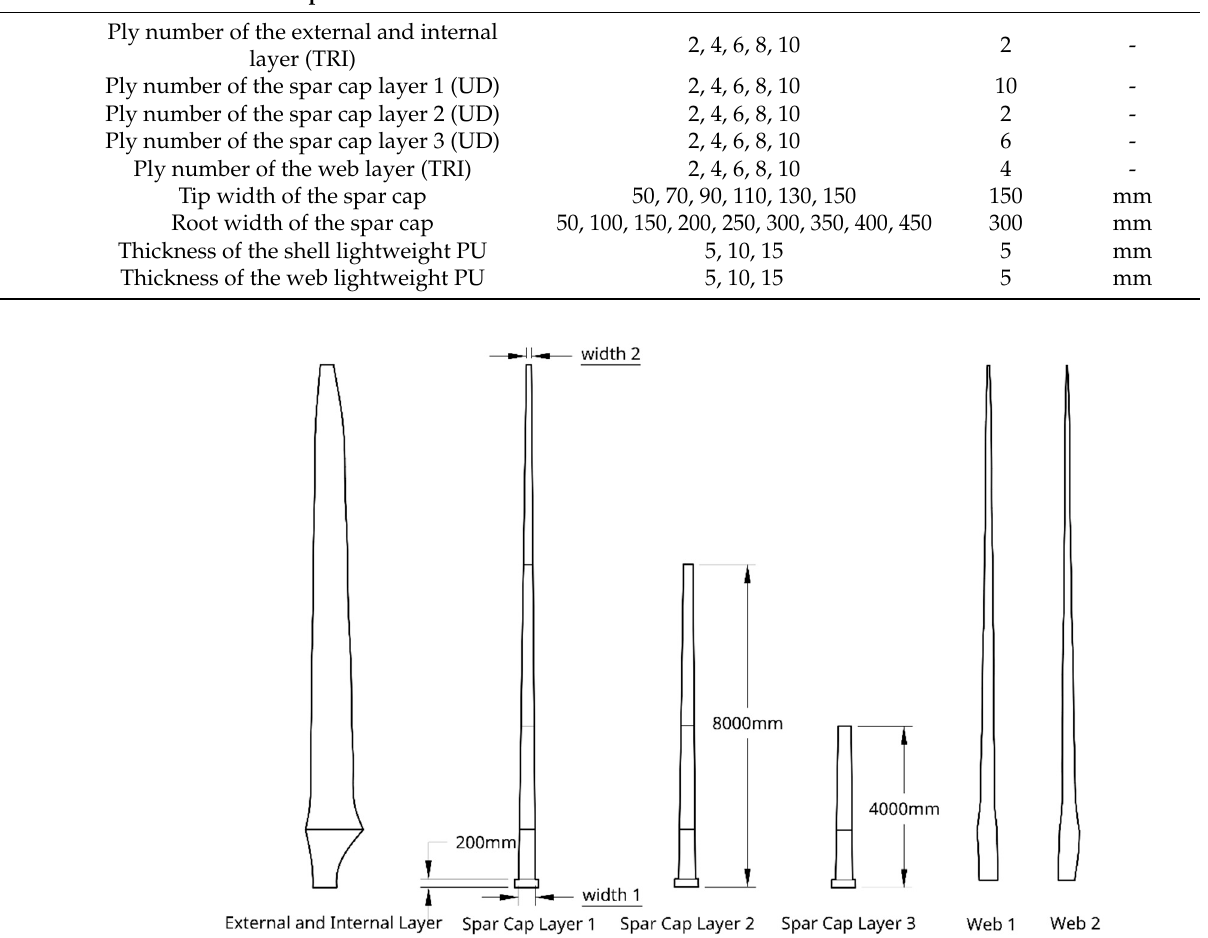
Figure 10. Composite layers of the new wind turbine blade. Table 8. Variables considered in the blade structural design.